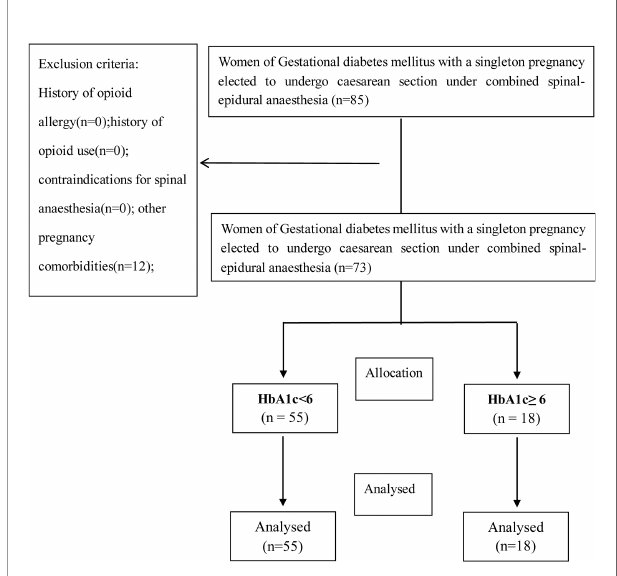
FIGURE 1 | Consort recruitment fl ow